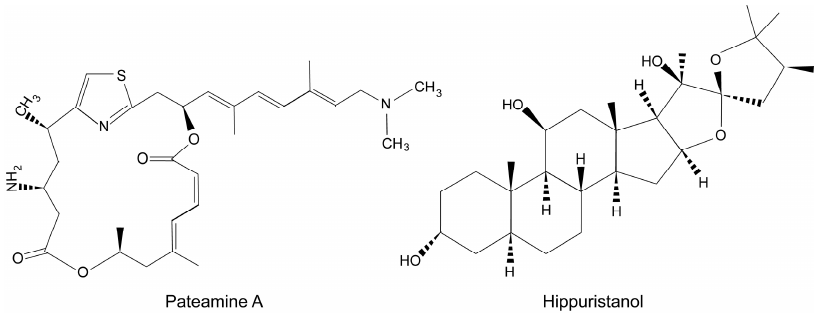
Figure 4. Chemical structure of pateamine A and hippuristanol.